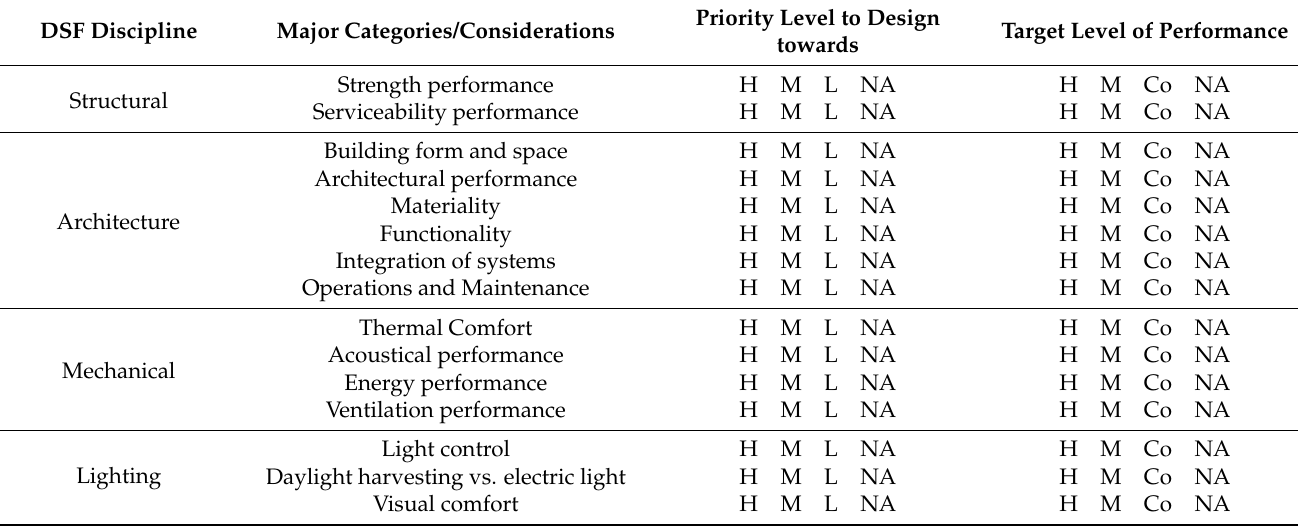
Table 18. Modeling Check List of Items to